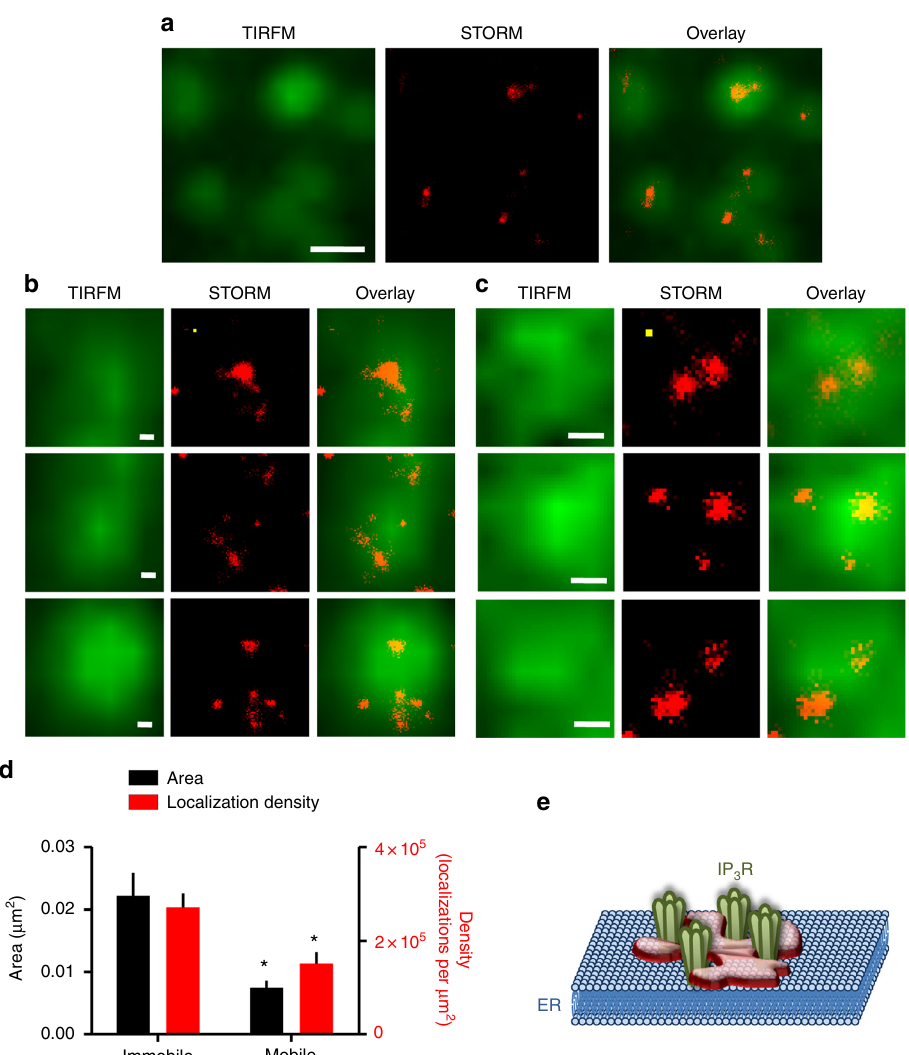
Fig. 4 EGFP-IP 3 Rs are diffusely distributed within puncta. a Examples of TIRFM and subsequent STORM images of EGFP-IP 3 R1 puncta. Scale bar = 0.5 µ m. b , c Before STORM, mobile and immobile puncta were identi fi ed using TIRFM and by overlaying pseudocoloured images collected at 10-s intervals (Supplementary Fig. 7). Examples of TIRFM and STORM images show immobile ( b ) and mobile puncta ( c ). Overlays show that EGFP-IP 3 R1s are diffusively distributed within mobile and immobile puncta. Scale bars = 100 nm. The yellow squares show approximate dimensions of an IP 3 R (20 nm × 20 nm). d Analysis of STORM images shows the area enclosing all EGFP-IP 3 R1s within each punctum and the density of localization events within the punctum for mobile and immobile puncta (mean ± SD for 4 – 6 puncta). * P < 0.05, Student ’ s t -test, relative to immobile puncta. Results show that mobile puncta are smaller and contain fewer IP 3 Rs than immobile puncta. e Many IP 3 Rs within puncta are too diffusively distributed to allow direct interactions between them. Although we used a non-oligomerizing EGFP to tag IP 3 R1 and minimize potential artefacts, the diffuse spacing of some EGFP-IP 3 R1s con fi rms that puncta are not formed by interactions between